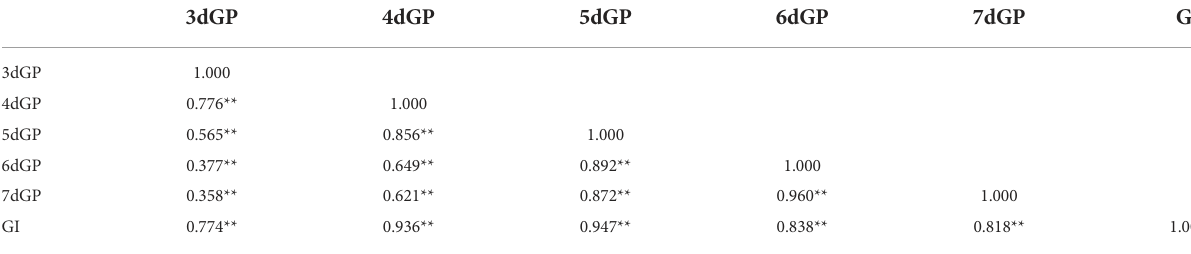
TABLE 2 Correlation analysis of germination potential (GP) on different days and germination index (GI) under salt